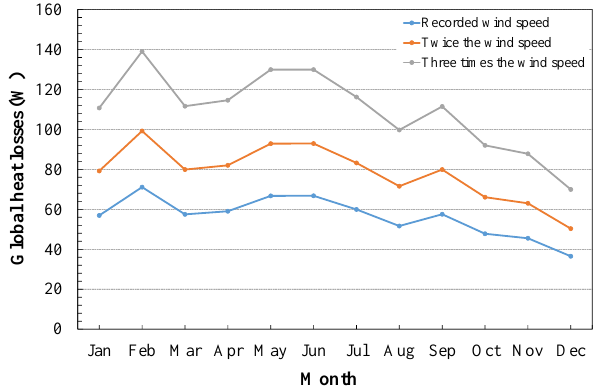
Figure 5. Effect of forced convection losses on receiver (adapted from Robbert, 1993). Figure 6. Theoretical analysis of the influence of the wind speed in the system heat